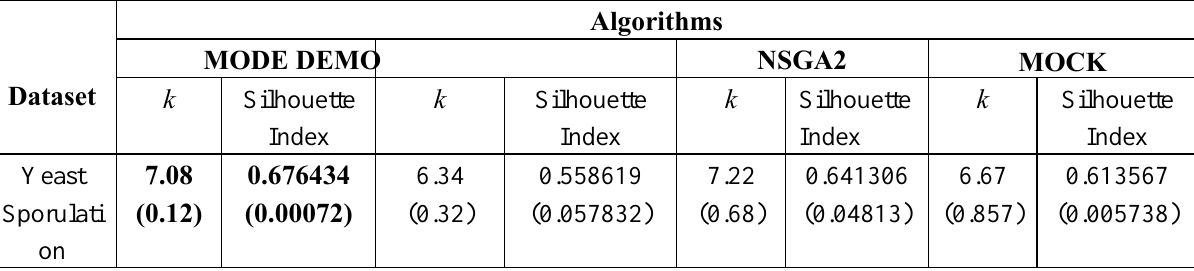
Table 3. Average Silhouette index and number of clusters found and standard deviations (in parentheses) by four contestant algorithms over 30 independent runs on the Yeast sporulation